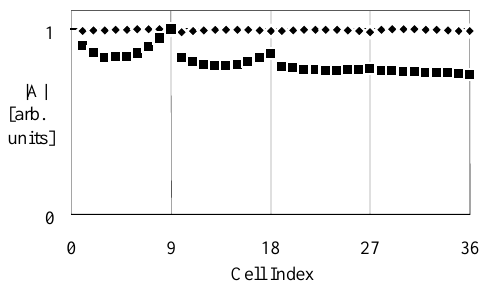
FIG. 7. Computed amplitudes in an LCR replacement circuit of four 9-cell TTF cavities: (cid:115) (cid:106) (cid:100) (cid:81) (cid:48) (cid:173) (cid:50)(cid:46)(cid:53) 3 (cid:49)(cid:48) (cid:52) , (cid:115) (cid:114) (cid:100) (cid:81) (cid:48) (cid:173) (cid:51) 3 (cid:49)(cid:48) (cid:49)(cid:48) and (cid:81) (cid:173) (cid:51)(cid:46)(cid:52) 3 (cid:49)(cid:48) (cid:54)